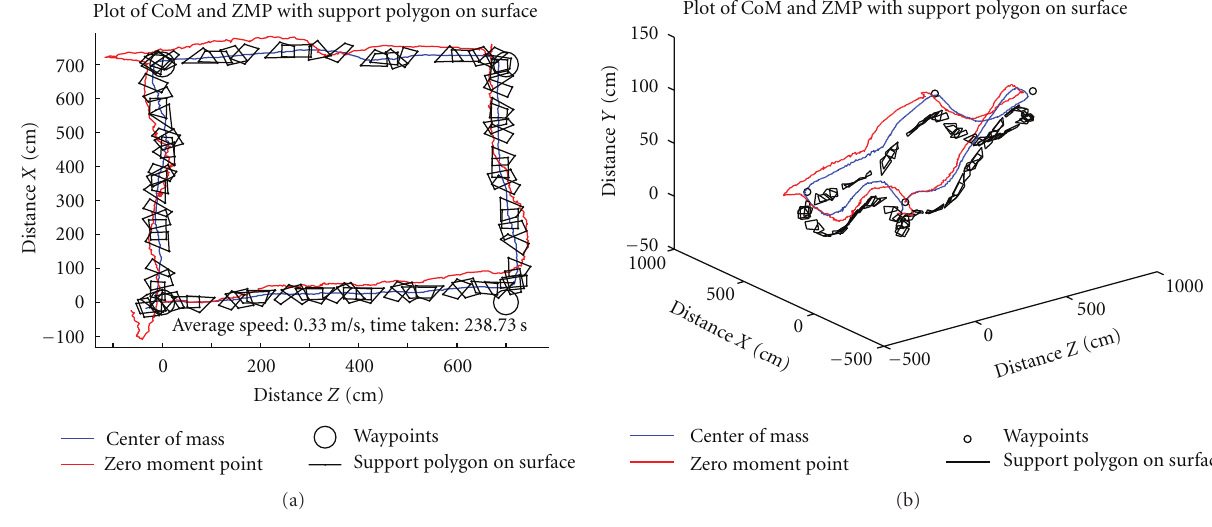
Figure 11: Plot of CoM and ZMP with SPOS without using the Foothold Reflex Control method.